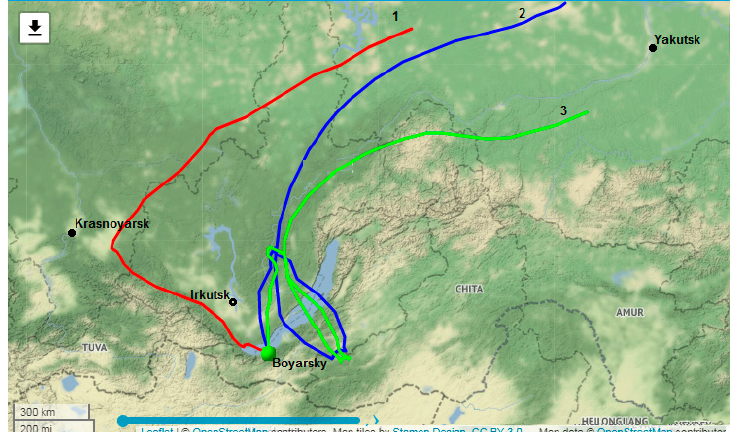
Figure 8. Seven-day back trajectories of the air mass transport to the Boyarsky settlement during the aerosol sampling on 9 August 2020, which were brought at heights of 100 m (1), 1000 m (2), and 1500 m (3) [24].